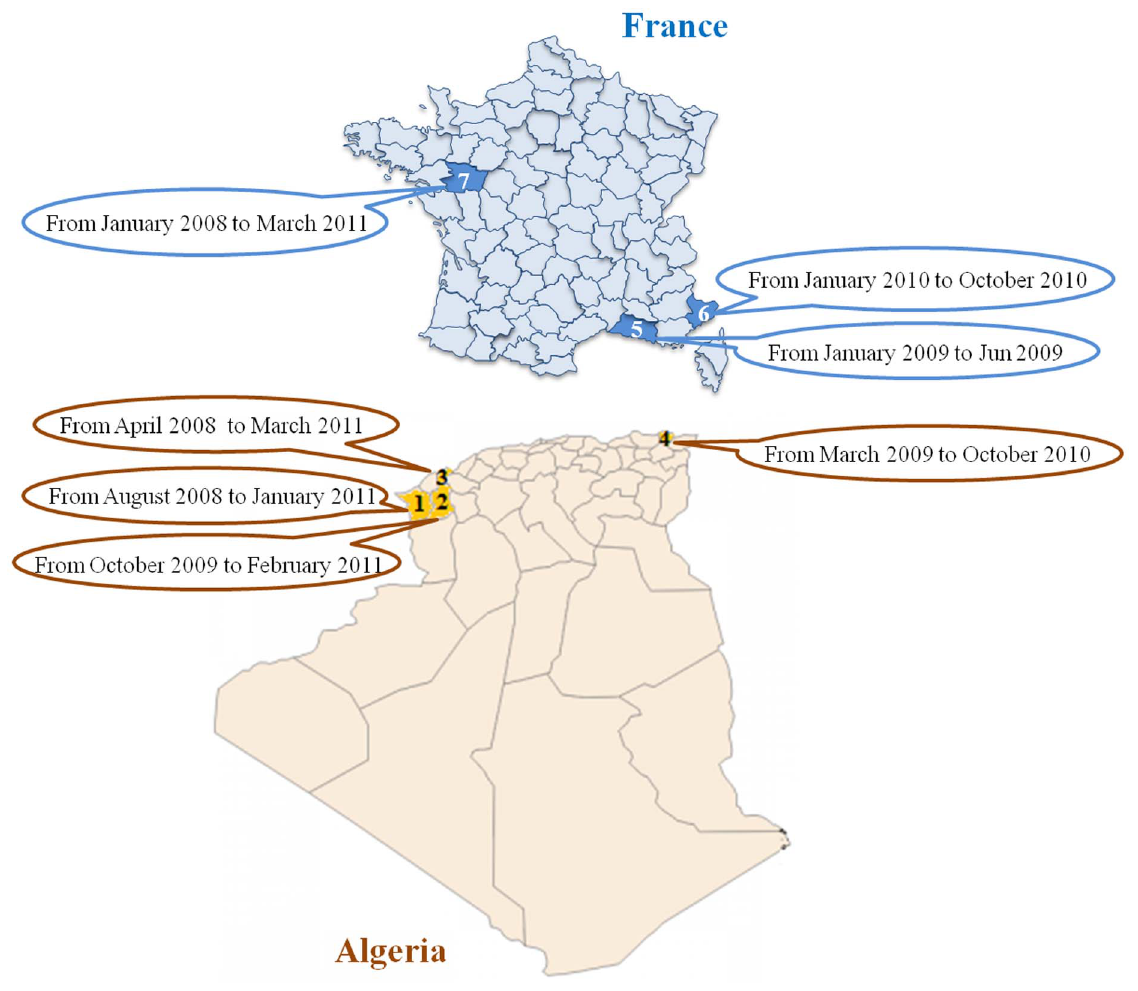
Figure 3. Minimal spanning tree (MST) of K.pneumoniae isolates, showing relationships between STs, compared with clusters obtained from the dendrogram generated by BIOTYPER software.